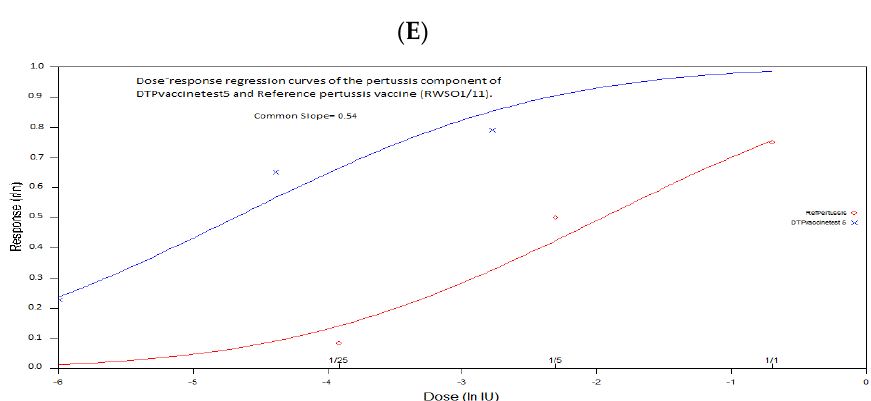
Figure 2. Estimation of dose response regression lines of the pertussis component of DTP vaccine test and reference pertussis vaccine (RWSO1/11) by the parallel line method using WHO combistats software(dose response regression curves of the proportion of surviving mice transformed to a probit as a function of the dose): ( A )The pertussis component of DTP vaccine test 1 and reference pertussis vaccine (RWSO1/11),( B ) the pertussis component of DTP vaccine test 2 and reference pertussis vaccine (RWSO1/11),( C ) the pertussis component of DTP vaccine test 3 and reference pertussis vaccine (RWSO1/1), ( D ) the pertussis component of DTP vaccine test 4 and reference pertussis vaccine (RWSO1/11) ( E ) the pertussis component of DTPvaccine test5 and reference pertussis vaccine (RWSO1/11). Table 4. Estimation of the weighted geometric mean of the relative potency of the pertussis component of DTP vaccine tested (DTP vaccine test 1 and vaccine test 5). Statistical analysis for homogeneity ( p ≥ 0.05) was performed using the chi-squared test under WHO combistats